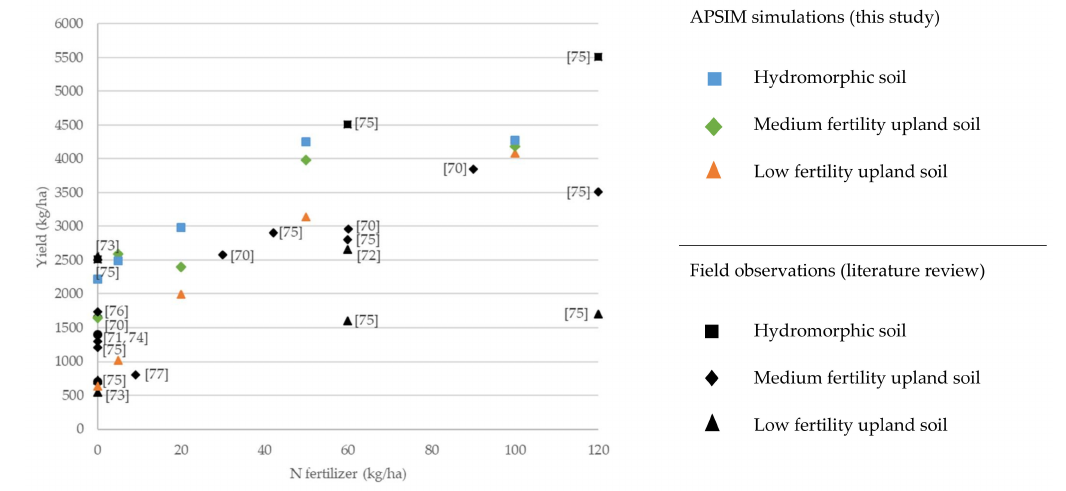
Figure 4. Maize simulated vs. published observed grain yields per fertilizer input level and soil fertility class. Numbers within brackets [] ([70–77]) indicate the reference of the publication from which data was retrieved.